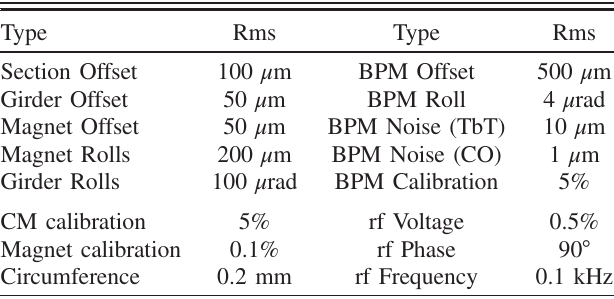
TABLE II. Errors assumed in the commissioning